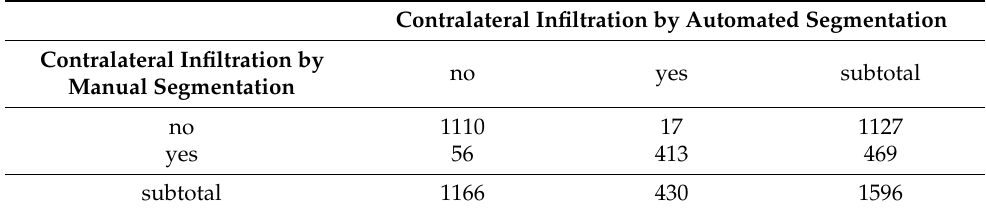
Table 3. Contingency table of contralateral infiltration between automated and manual